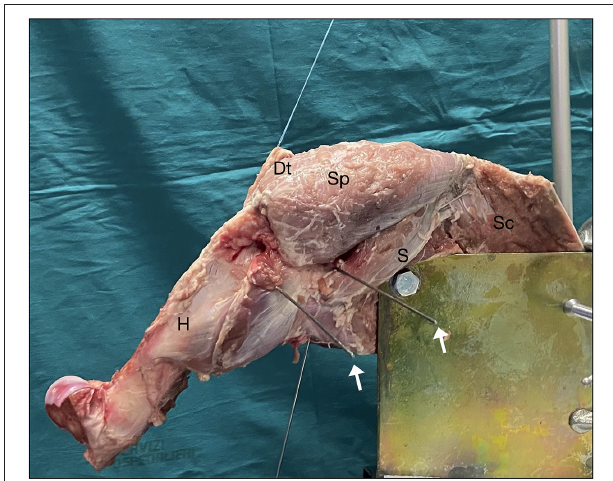
FIGURE 1 | Shoulder fixed to the system prepared for test. The deltoid tendon (Dt) is basted for the application of forces. White arrows: K-wires located as explained in the text. Sp, sopraspinatus; S, subscapularis; SC, scapula; H, humerus.